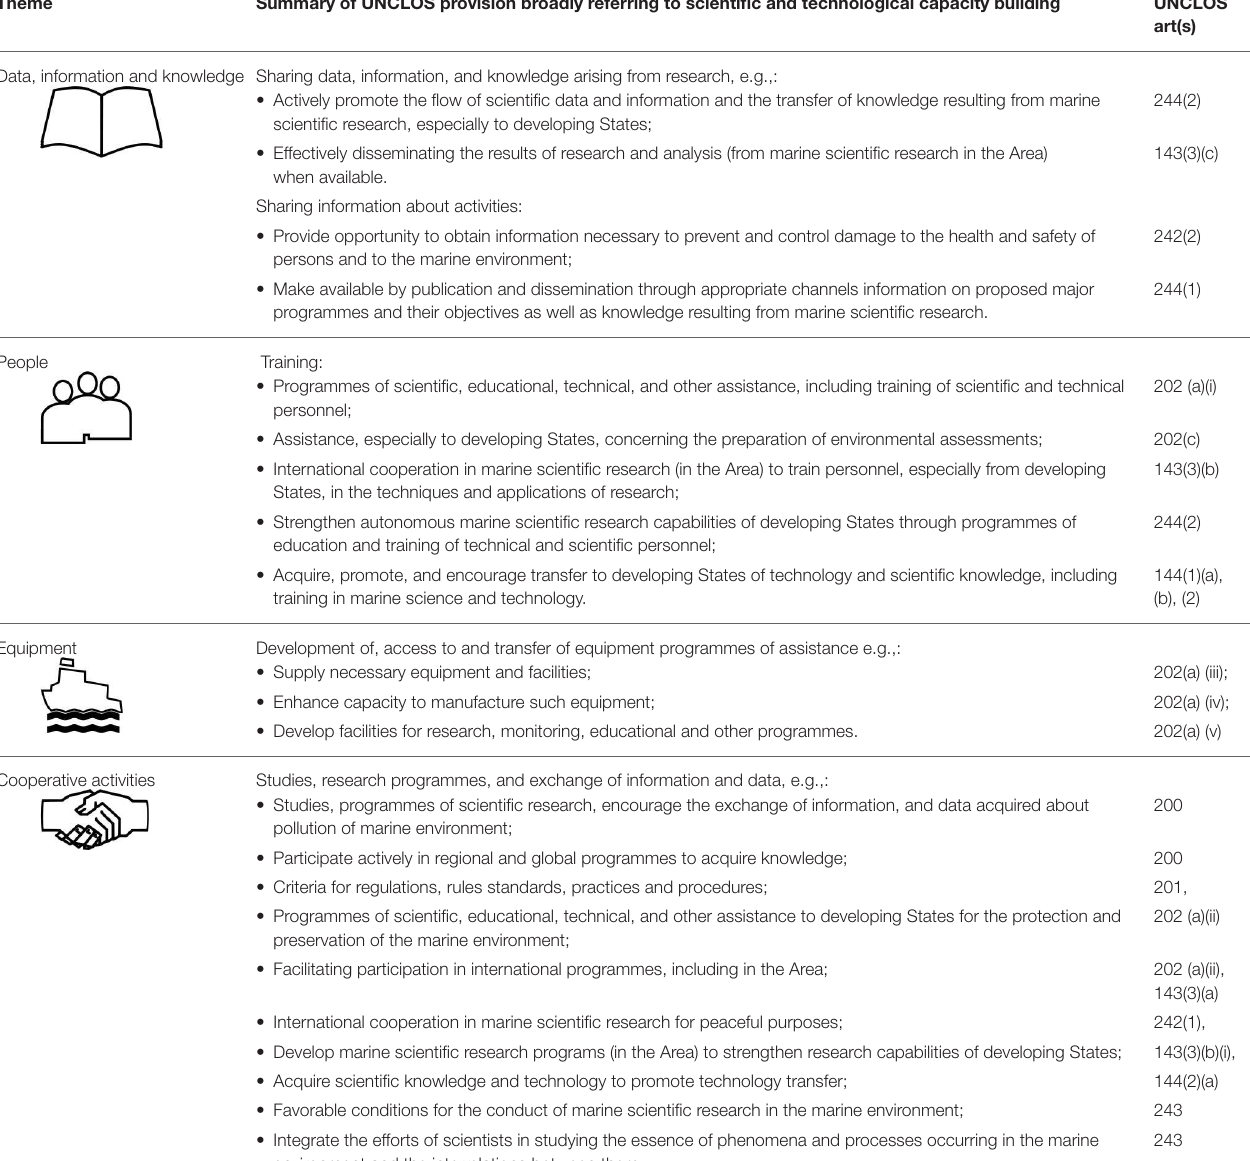
TABLE 3 | Summary of provisions relating to scientific and technological capacity building in UNCLOS Parts XI (the Area), XII (protection and preservation of the marine environment), and XIII (marine scientific research). Theme Summary of UNCLOS provision broadly referring to scientific and technological capacity